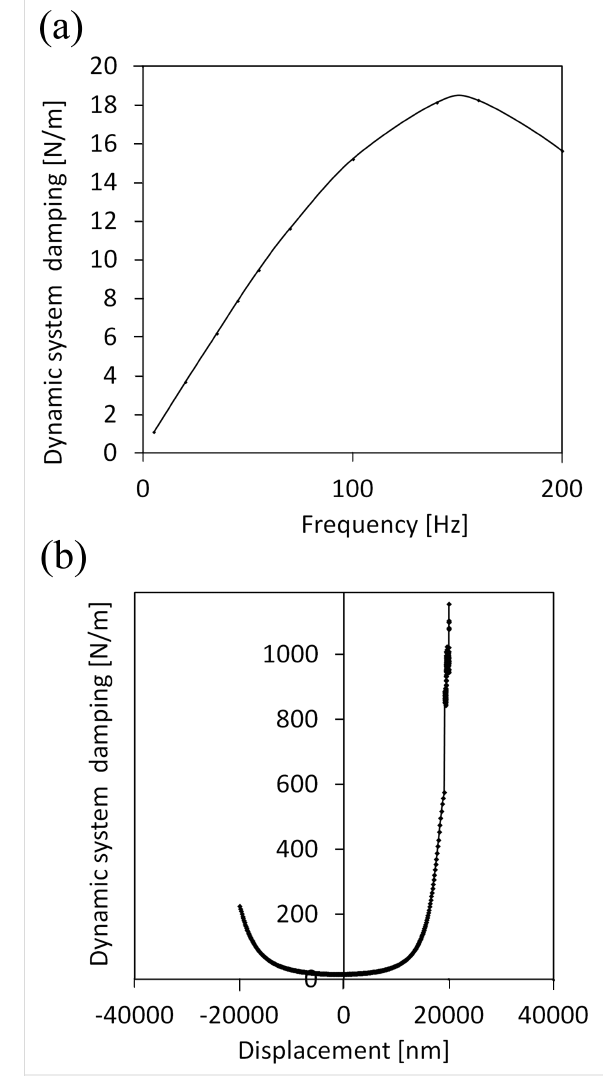
Figure 6: Calibration of the system damping for INI. The damping was computed for each frequency at different vertical extensions of the indenter over a range of ± 30 μ m. The damping is computed by using Equations 9–11 and is reported here as C i ω . (a) System damping as a function of the frequency for a displacement near 0. (b) System damping as a function of the displacement of the indenter head at 200 Hz